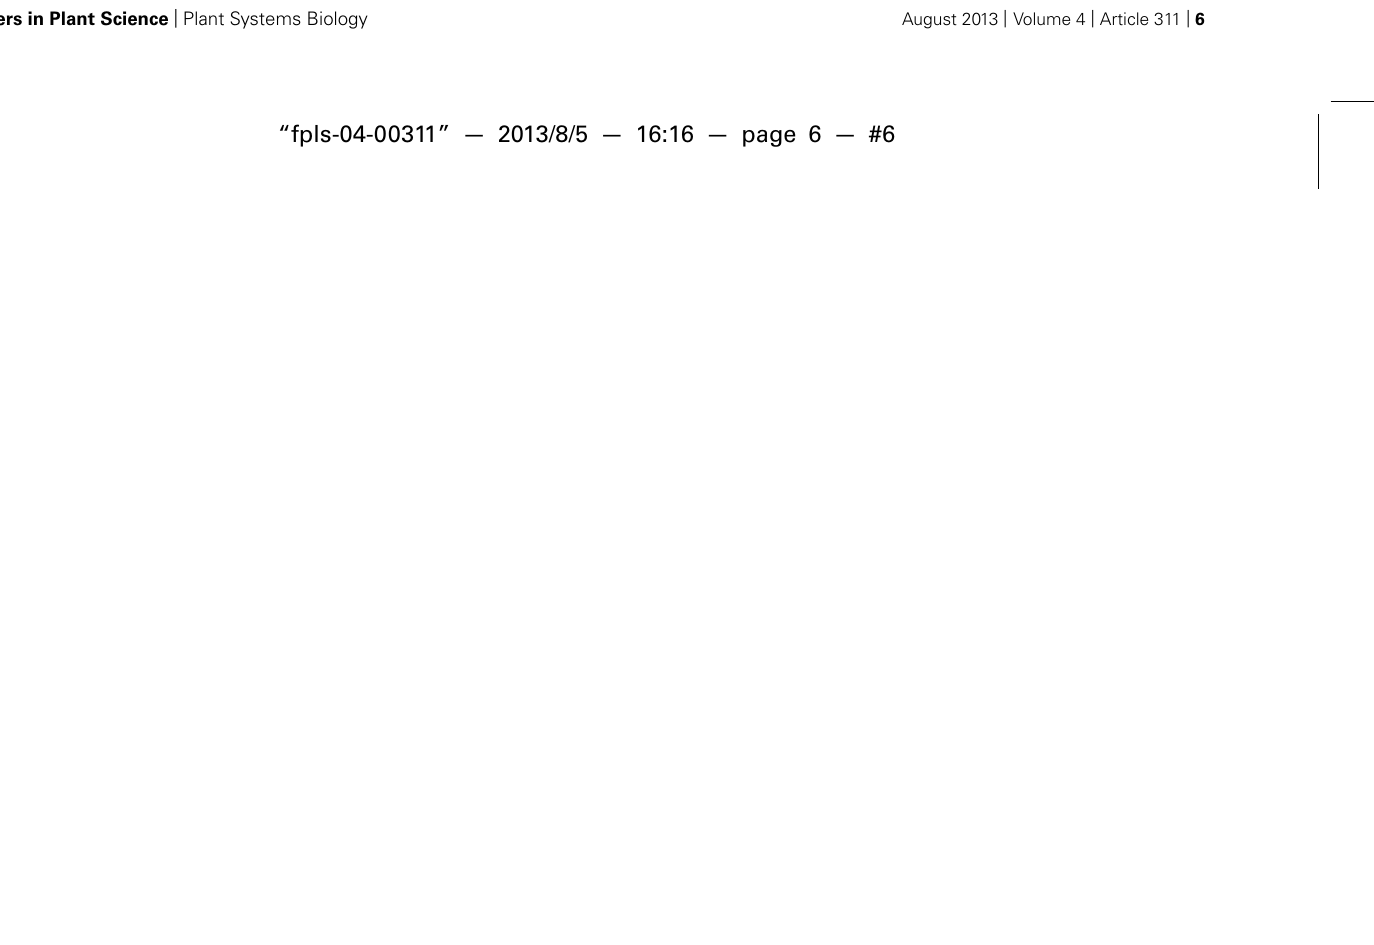
FIGURE 6 |TargetingVSFPs to different membrane systems. The plasma membrane (PM) and the inner and outer nuclear membranes (INM and ONM, respectively) are represented by concentric black partial and full circles. For simplicity, the nuclear pores, at which the INM and ONM are fused, are omitted.The ONM is continuous with the endoplasmic reticulum (ER).The perinuclear space (PNS) between the INM and ONM is contiguous with the lumen of the ER.Targeting ofVSFPs to the PM is achieved by Ci-VSP ( Figure 3 ). Ideally, targeting signals specific for the INM and ONM can be identified since these two membranes may have distinct and independently regulated potentials. Using differentVSFPs in the PM and ONM (or INM) would allow multicolor imaging and simultaneous monitoring of potentials at different membrane systems within a single cell. Shown here is the hypothetical situation of FRET-basedVSFP2.3 in the PM (or INM) and intensity-basedVSFP3.1TagRFP in the ONM.The dotted arrow and question mark indicate the possibility of detecting synchronous changes in PM and ONM (or INM) potentials